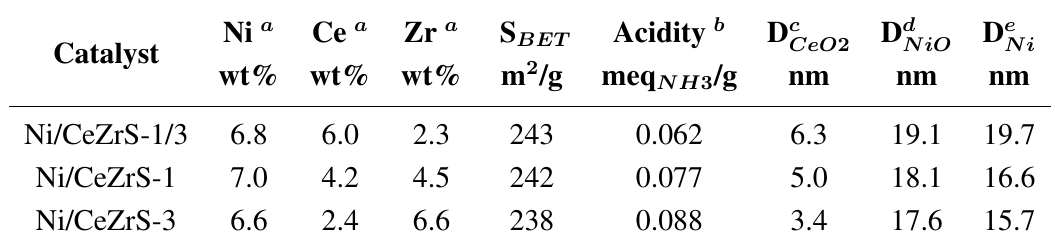
Zr O /SiO x 1 − x 2 2